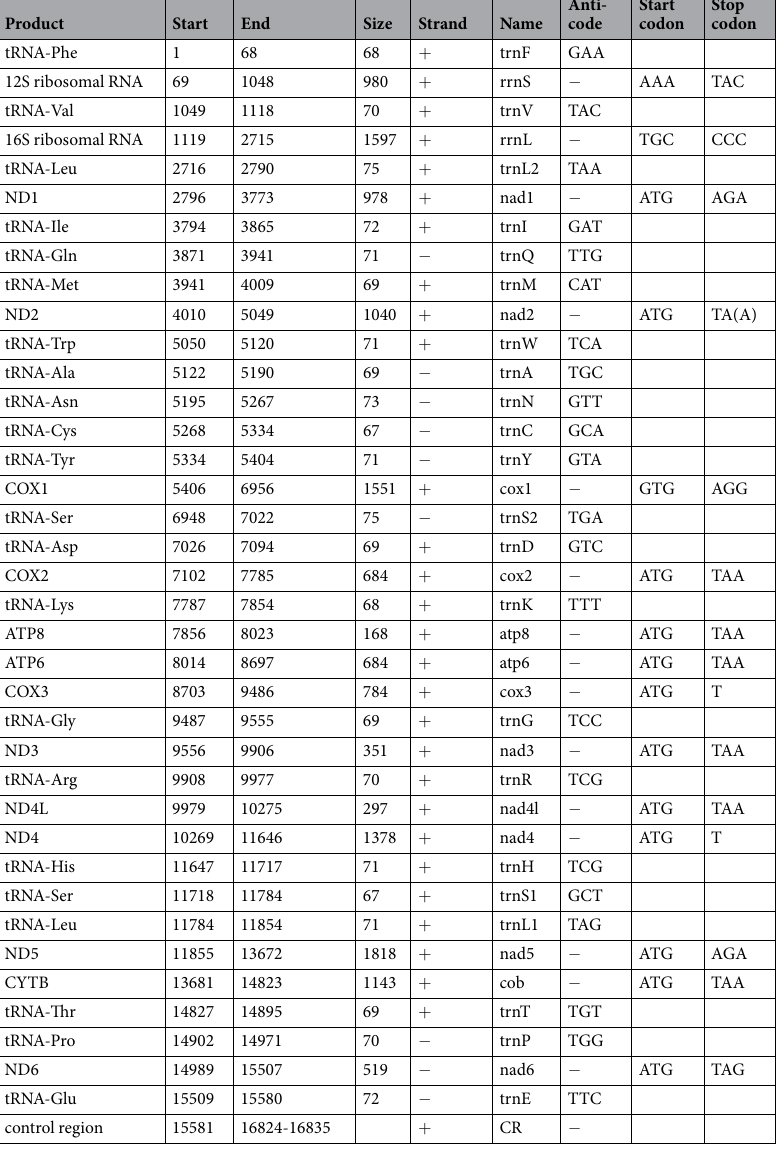
Table 1. Annotation of assembled mitochondrial genome of Oenanthe oenanthe